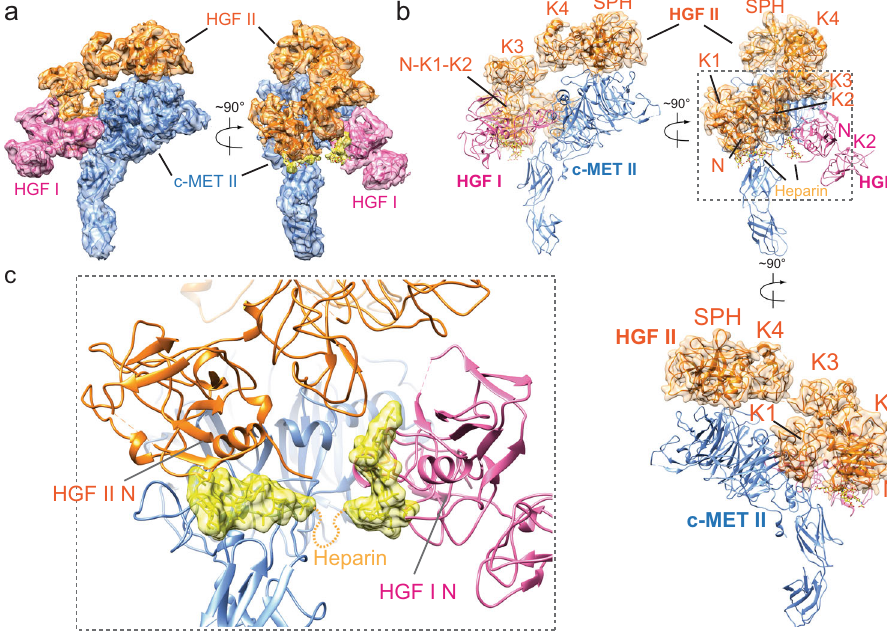
Fig. 5 A rigid HGF II stabilizes the interaction between c-MET II and HGF I. a 3D reconstruction of the c-MET II/HGF I bound with an HGF II with rigid conformation, and the corresponding ribbon representation of this complex fi tted into the cryo-EM map at 4.9 Å resolution, shown in two orthogonal views. b The ribbon representation of c-MET II/HGF I in complex with a complete version of HGF II shown in two orthogonal views. The model of the intact HGF II is also shown as surface representation. c Detailed view of heparin-binding at the N domains of HGF I and II. A long heparin polymer could mediate the interaction between HGF I and II. The heparin molecules are shown as surface